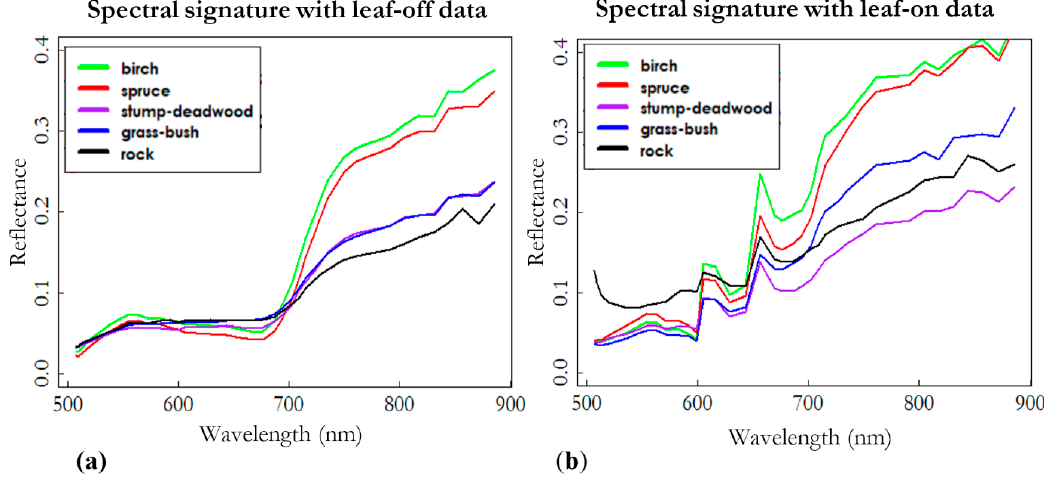
Figure 2. Mean spectra of training data in five classes, in leaf-off ( a ) and leaf-on ( b ). The optimal bands found and used for creating VIs are given in Table 6 for each epoch. Table 6. Wavelengths used for calculating vegetation indices.